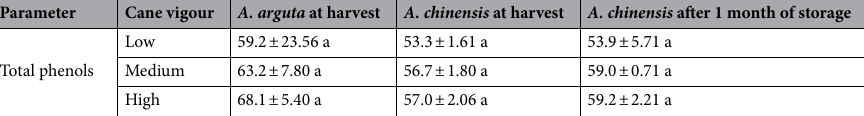
Table 7. Total phenols (mean ± SE, in mg of gallic acid equivalents/100 g fresh fruit) in fruit of A. arguta and A. chinensis . Mean values followed by the same letter within a column do not differ significantly.